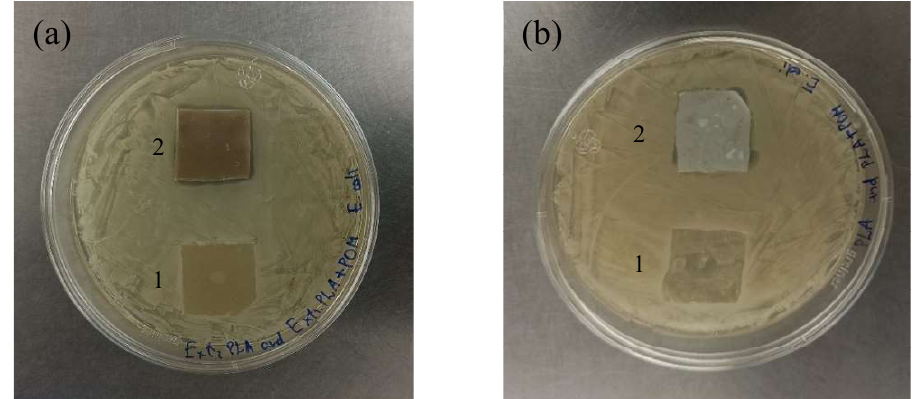
Figure 8. Agar diffusion test for E. coli showed the inhibition zone presence: ( a ) Films obtained by electrostatic extrusion method; the control blank Extr. PLA film is marked with 1, while the Extr. POM/PLA composite film is marked with 2. ( b ) Films obtained by solvent casting method; the control PLA film is marked with 1, while the POM/PLA composite film is marked with 2.